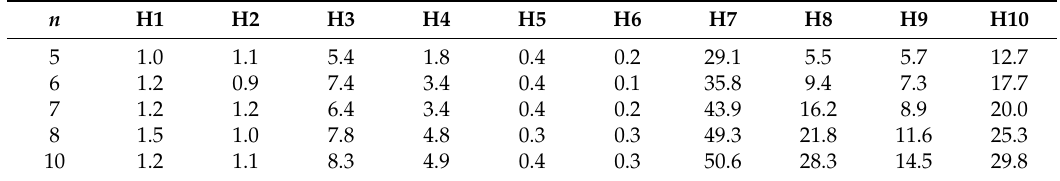
Table 5. Comparison of performances (RPD) of heuristics by number of jobs for Group 1.